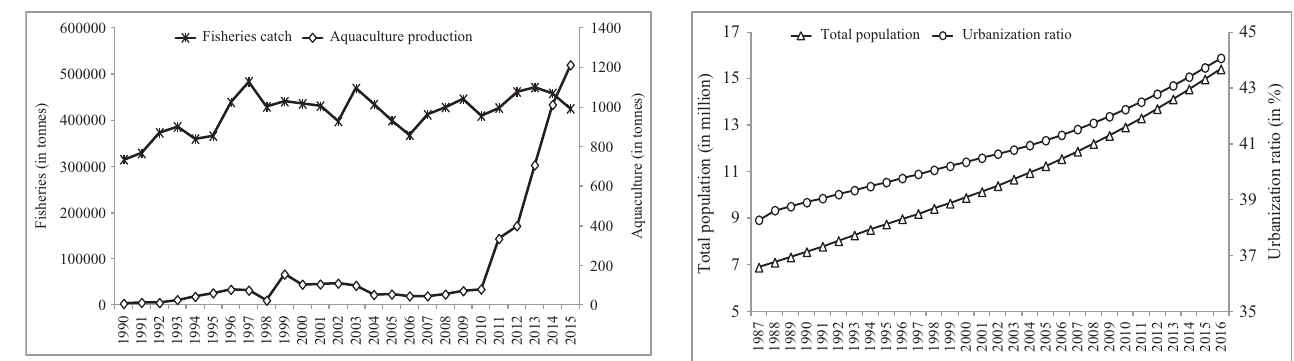
Fig. 6. Increase in total population and the urbanization rate in Senegal from 1987 to